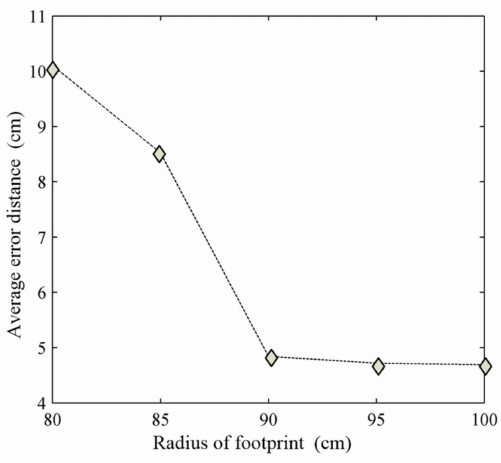
Figure 16. Effects of footprint radius on the average positioning